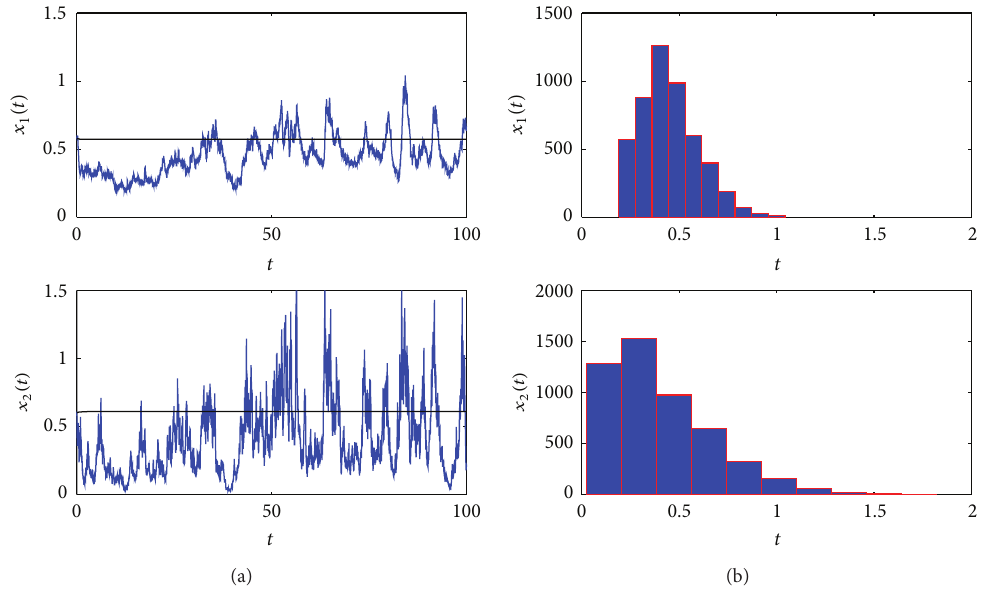
= 0.2 , 𝜎 = 0.3 in the right subgraph (b). 1 2